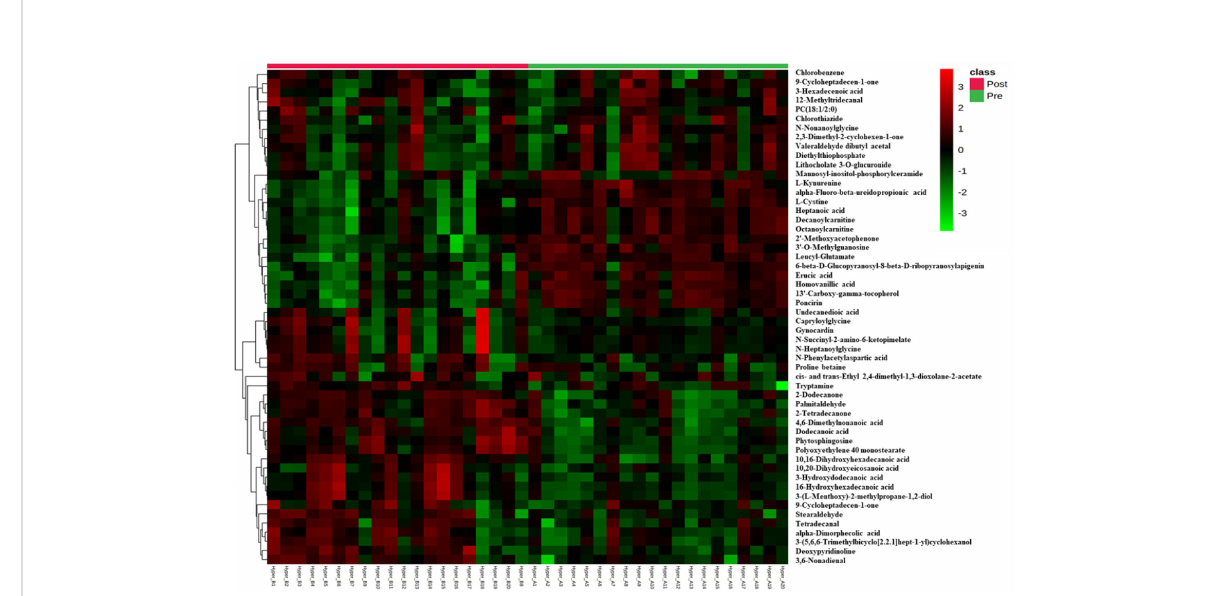
FIGURE 2 Heatmap of untargeted LC-MS analysis of biologically relevant and signi fi cantly altered metabolites between pre and post-antithyroid drug administration groups. Red and green colors refer to signi fi cantly up- and down-regulated metabolites,